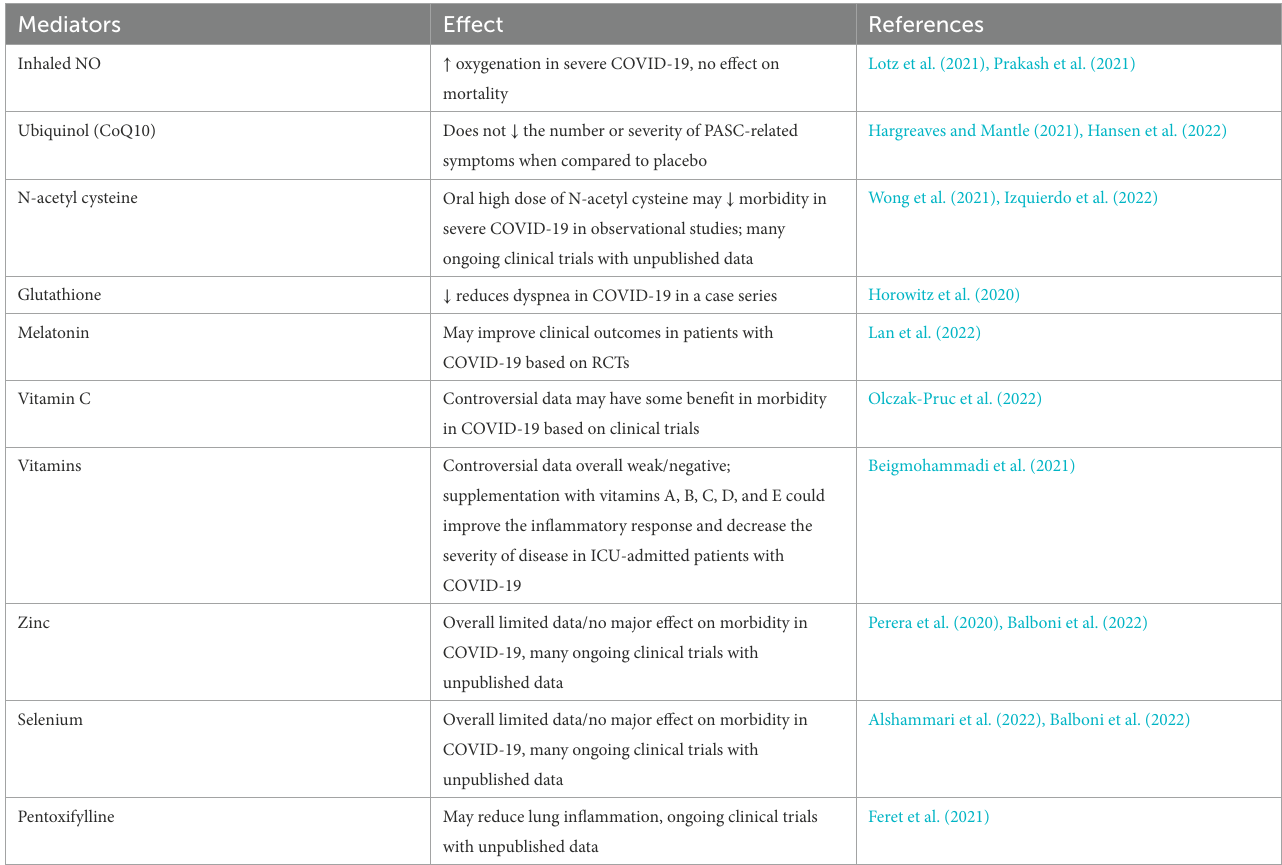
TABLE 4 Antioxidant treatments that have been tested in humans for treatment of coronavirus infections.